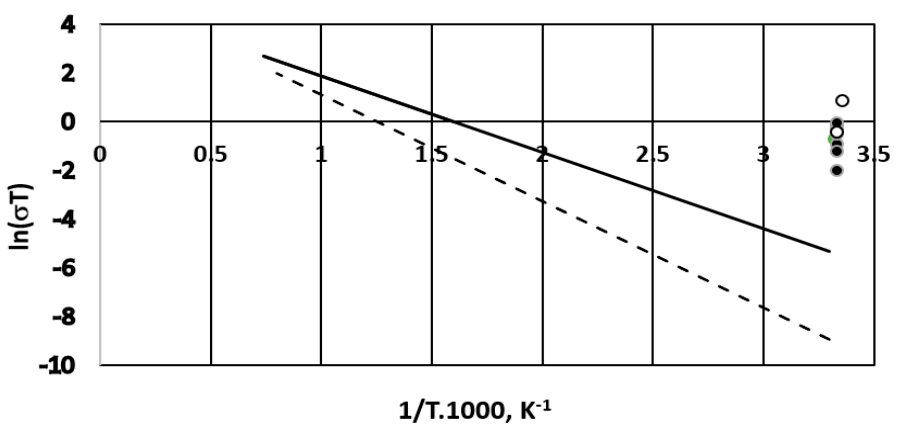
Figure 14. Comparison of cell conductivity with different ion exchange membranes to solid membrane conductivity (cf. [30], pp. 154–196). Solid line—Gd doped ceria; dashed line—ytria stabilized